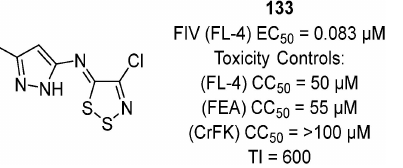
Figure 27. Most potent compound 133 active agiants FIV in the 2022 study by our group [36].